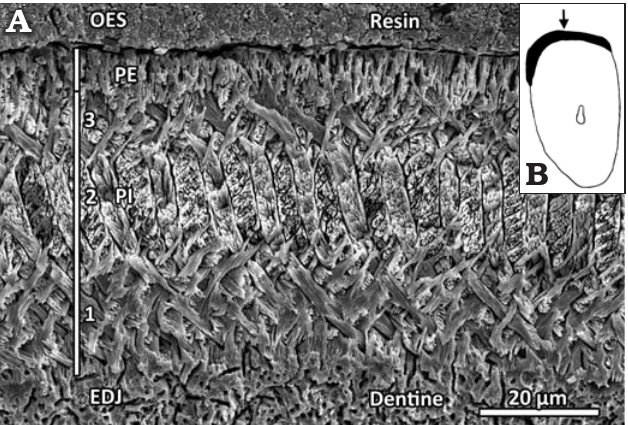
Fig. 4. Lower incisor (NMNS-PV19994, paratype) of eomyid rodent Japa- neomys yasunoi gen. et sp. nov. A . SEM image of the enamel microstruc- ture. Transverse section showing the four-layered schmelzmuster with a thick, tripartite Portio interna (PI) and a thin Portio externa (PE); EDJ, enamel-dentine-junction; OES, outer enamel surface. This section is lo- cated directly right (medial) to the arrow in B. B . Schematic drawing of the incisor cross section. The enamel band is shown in black, the solid arrow points to the shallow groove. The magnification is about